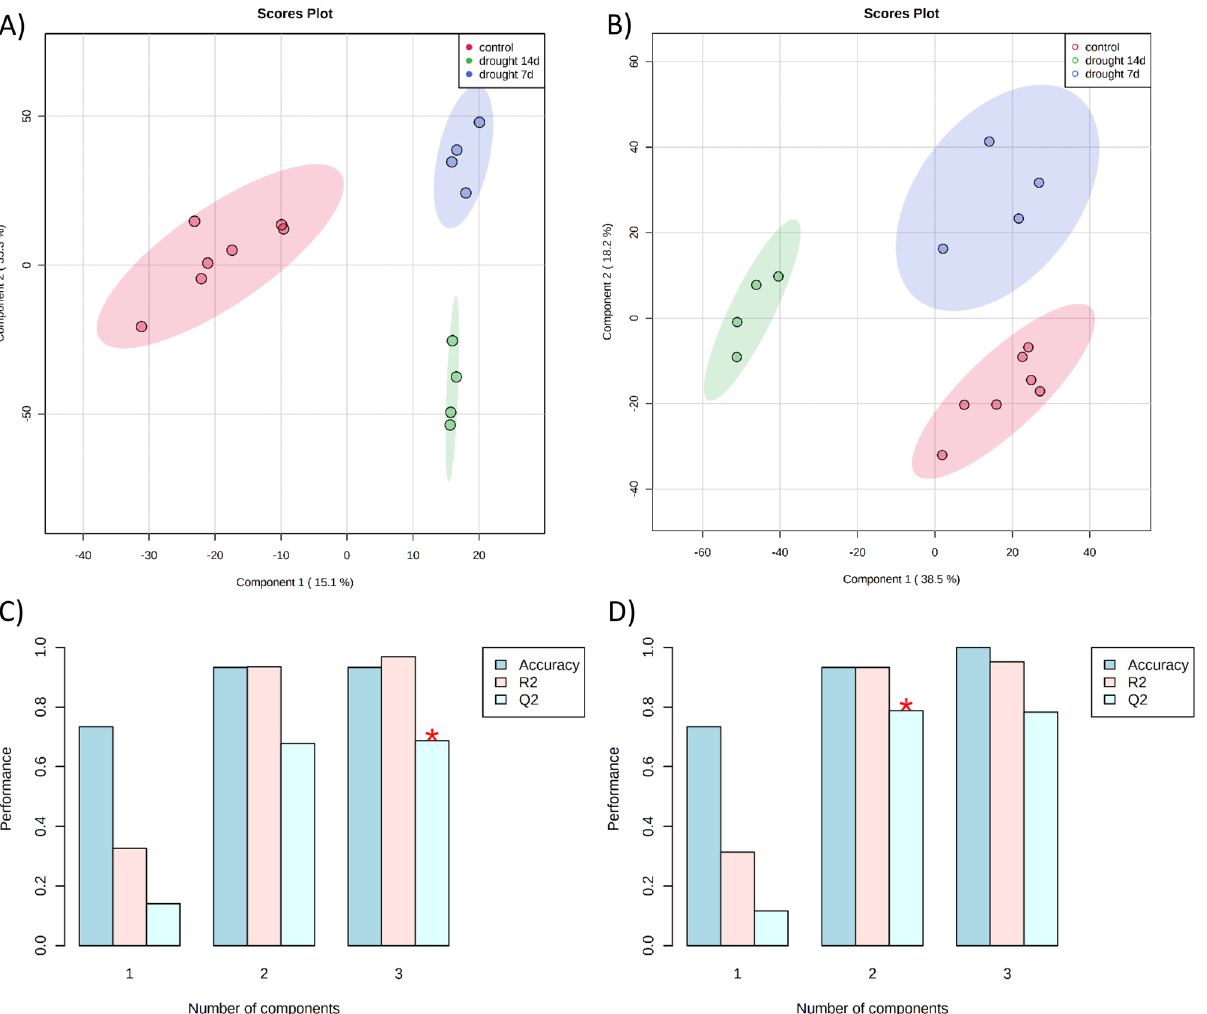
Figure 2. PLS-DA score plots comparing drought/control groups and “leave-one-out” cross validation (LOOCV). ( A ) Positive mode PLS-DA scores plot. ( B ) Negative mode PLS-DA scores plot. ( C ) LOOCV in positive mode. ( D ) LOOCV in negative